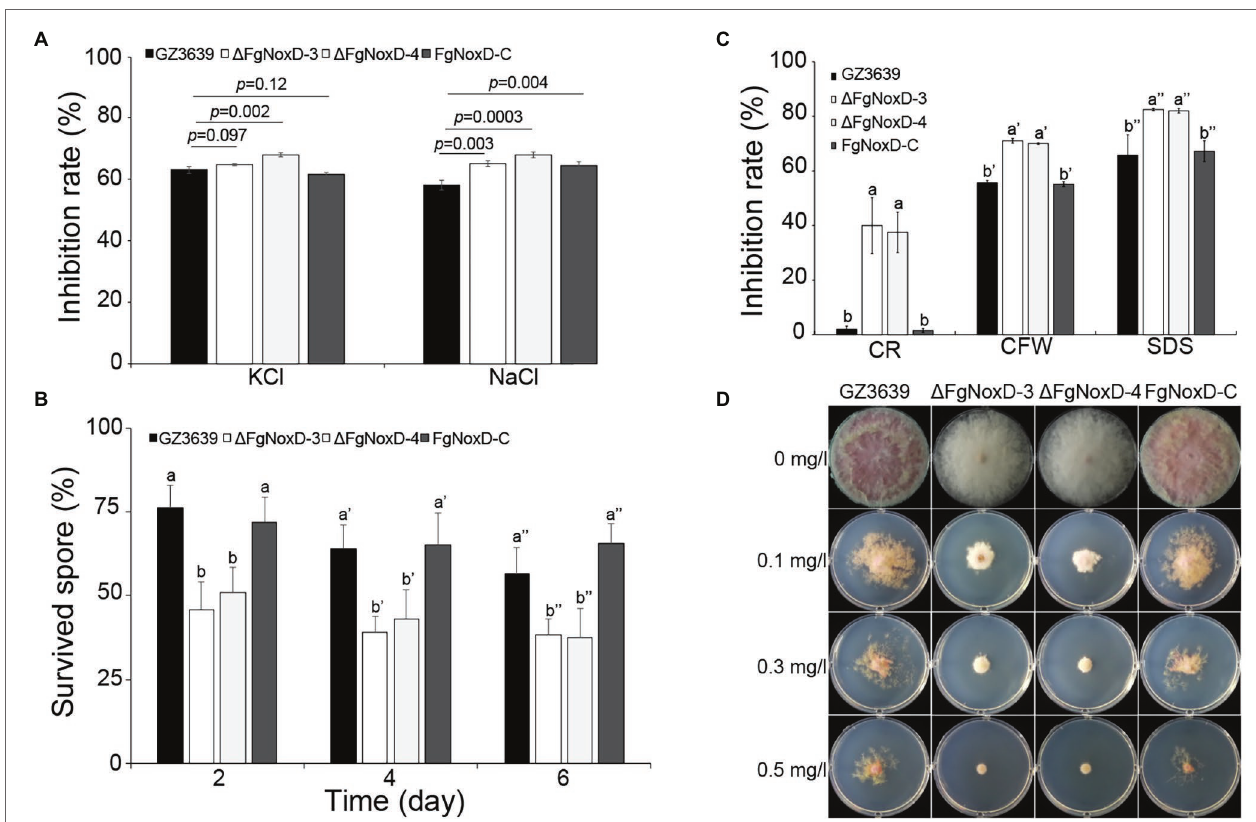
FIGURE 3 | Resistance of GZ3639, Δ FgNoxD, and FgNoxD-C to various stresses. (A) Osmotic stress: strain was cultured in MM supplemented with 1.4 M KCl and NaCl for 5 days. Error bars represent the SE from five replicates. (B) Cold stress: 10 3 conidia/ml of each strain were stored at 4 ° C for 6 days in distilled water. One hundred microliter of each conidia suspension was spread onto PDA and the survived spore was counted after 1 day. Error bars represent the SD from five replicates. (C) Cell membrane and cell wall stress test. All strains were cultured in MM without or with 60 mg/L congo red (CR), 50 μ g/ml calcofluor white (CFW), 0.01% SDS for 3 days. Error bars represent the SD from five replicates. Values with different letters are significantly different according to Tukey’s test ( p < 0.001). (D) Fungicide test: the strains were inoculated in MM containing different concentration of prochloraz for 5 days at 25 ° C. This experiment was repeated five